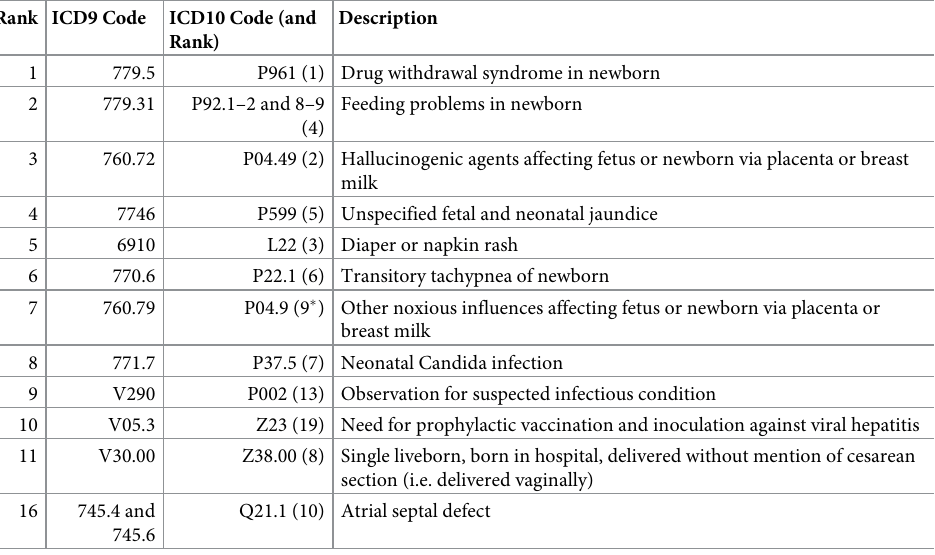
Table 2. Top ranked ICD9 and ICD10 codes associated with infants who have